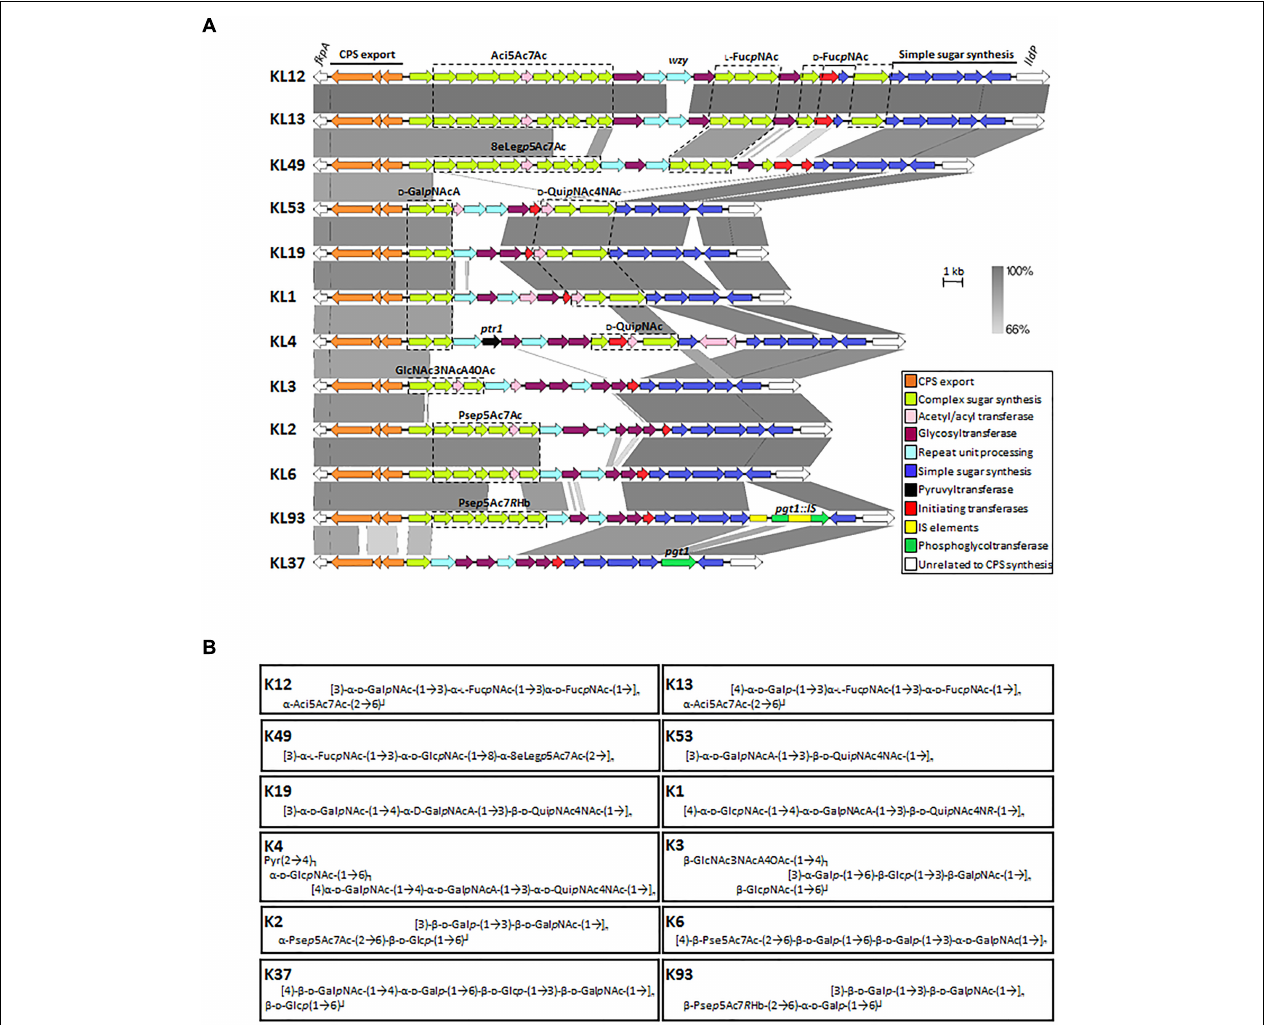
FIGURE 2 | Comparison of representative A. baumannii CPS biosynthesis gene clusters and corresponding structures. (A) Nucleotide sequences representing different KL regions focusing on genes between fkpA and lldP were obtained from the NCBI database and aligned using the Easyfig 2.2.2 tool (Sullivan et al., 2011). Genes are depicted by arrows and indicate direction of transcription whilst IS elements are represented by square boxes. Color scheme is based on homology to the putative function of gene products and are outlined in the key. Nucleotide sequence homology shared between regions is represented by color gradient. Figure is drawn to scale. Gene modules for sugar synthesis of interest are indicated, where Aci5Ac7Ac represents genes involved in the production of 5,7-di- N -acetylacineta- minic acid; L -Fuc p NAc, N -acetyl- L -fucosaminic acid; D -Fuc p NAc, N -acetyl- D -fucosaminic acid; 8eLeg p 5Ac7Ac, 5,7-diacetamido-3,5,7,9- tetradeoxy- L - glycero - D - galacto -non-2-ulopyranosonic (di- N -acetyl-8-epilegionaminic) acid; D -Gal p NAcA, N -acetyl- D -galactosaminuronic acid; D -Qui p NAc4NAc, 2,4-diacetamido- 2,4,6-trideoxy- D -glucopyranose ( N , N ’-diacetyl-bacillosamine); D -Qui p NAc, N -acetyl- D -quinovosaminic acid; GlcNAc3NAcA4OAc, 2,3-diacetamido-2,3-dideoxy - α - D -glucuronic acid with an additional O -acetyl group; Pse p 5Ac7Ac, 5,7-diacetamido-3,5,7,9-tetradeoxy- L - glycero - L - manno -non-2-ulosonic (pseudaminic) acid and Pse p 5Ac7 R Hb, 5-acetamido-3,5,7,9-tetradeoxy-7-(3-hydroxybutanoylamino)- L - glycero - L - manno -non-2-ulosonic acid. Genes of interest are labeled above corresponding gene, see text for further details. Genbank accession numbers for sequences used in gene alignment are as follows; KL12, JN107991.2 (38.5 kb region; base position range 2332–40832); KL13, MF522810.1 (38.2 kb region); KL49, KT359616.1 (34.5 kb region); KL53, MH190222.1 (23.4 kb region); KL19, KU165787.1 (23.8 kb); KL1, CP001172.1 (24.9 kb; base position range 366401 to 3691388); KL4, JN409449.3 (30.9 kb; base position range 2375 to 33327); KL3, CP012004.1, (25.4 kb; base position range 3762660–3788118); KL2, CP000863.1 (27.1 kb; base position range 77125–104246); KL6, KF130871.1 (25.5 kb); KL93, CP021345.1 30.3 kb (base position range 3338210–3368604) and KL37 KX712115.1 (23.4 kb). (B) Capsule structures corresponding to KL gene regions in (A) are shown. Percentage of O -acetylation of specific glycans from K53, K19, K1 are not represented in structural configurations (Kenyon et al., 2016a; Shashkov et al.,